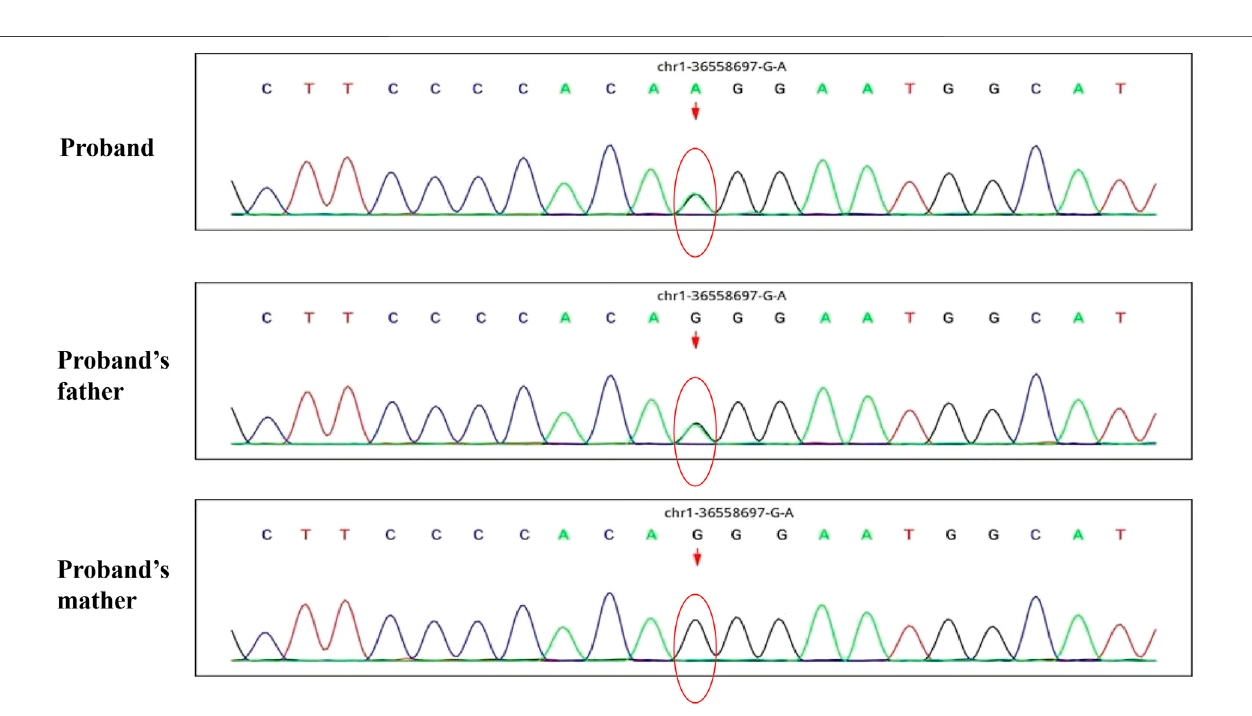
Frontiers in Genetics |